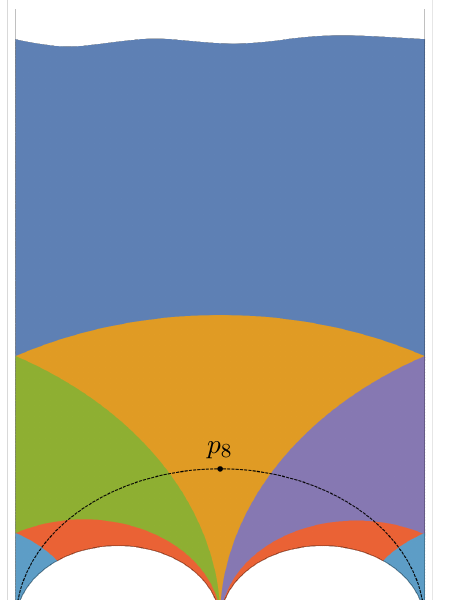
(4) + is obtained as X 0 = − ¯ p . p = i/ 2 is the fixed point of F 7 9 8